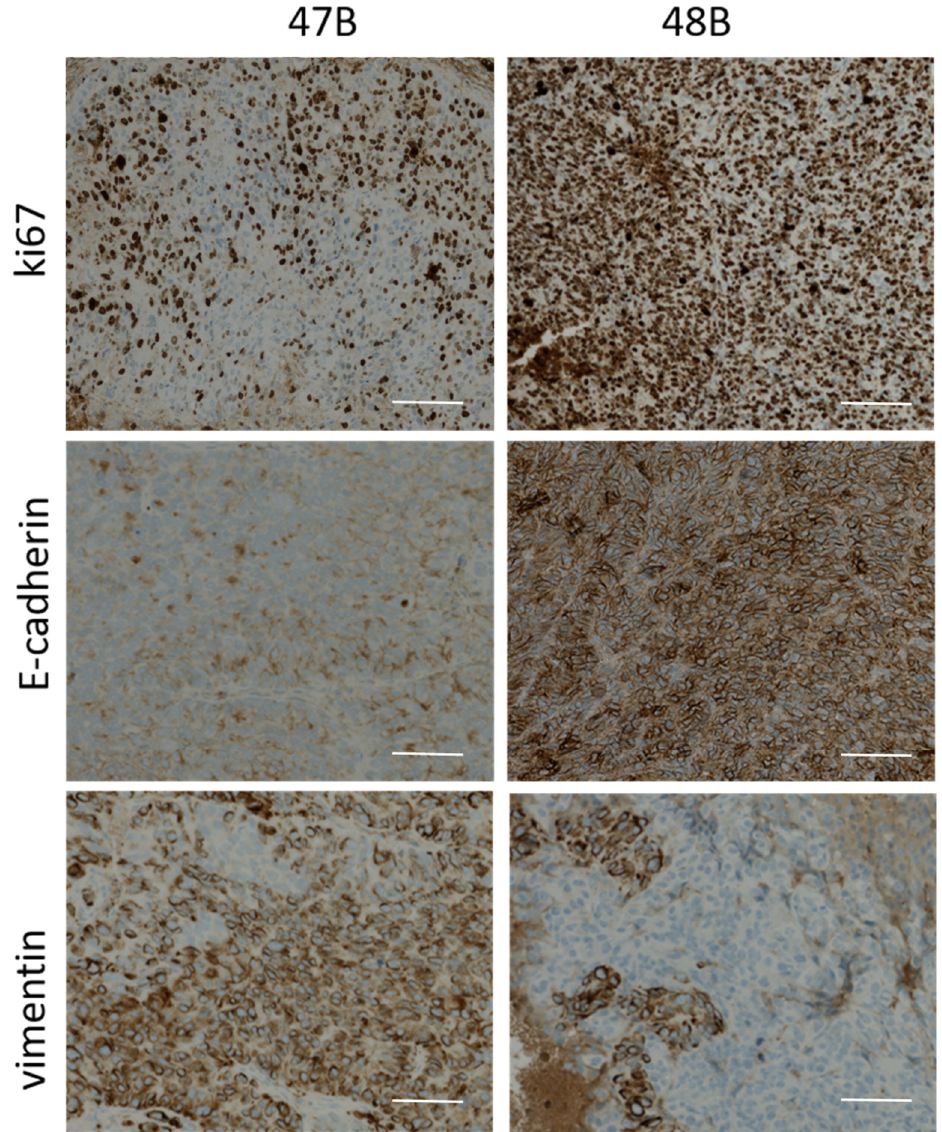
Figure 5. Expression of Ki-67, E-cadherin and vimentin in tumor samples 47B and 48B excised from tumor-bearing mice detected by immunohistochemistry as described in Materials and methods section. Bright-field microscopy 100×. Scale 50 µm.